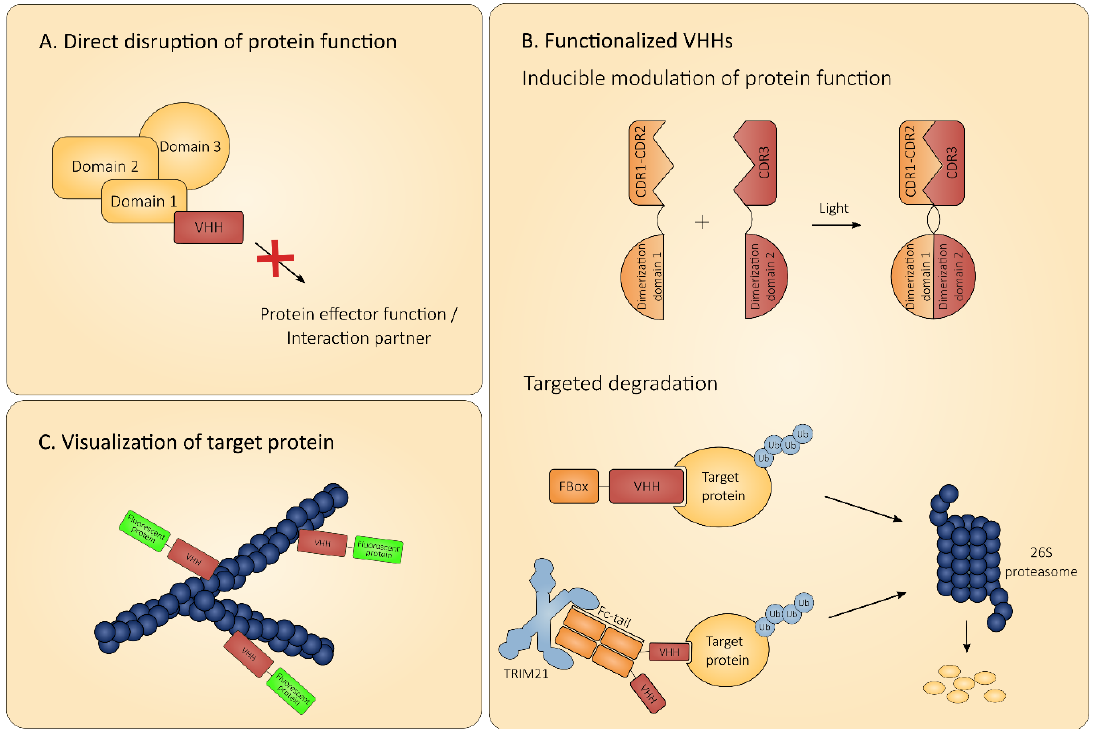
Figure 3. Schematic overview of the different uses of VHHs as research tools. ( A ) VHHs are able to target a particular protein domain, hereby inhibiting a specific protein effector function or a specific protein interaction. ( B ) VHHs can be coupled to functional groups. Creating a split VHH, coupled to light-sensitive dimerization domains, allows the precise timing of VHH modulation of target protein function [125]. On the other hand, coupling of VHHs to an F-box domain leads to the recruitment of cellular ubiquitin ligases, effectively marking the target protein for proteasomal degradation. Alternatively, coupling intracellular VHHs to and Fc-tail allows them to be recognized by tripartite motif-containing 21 (TRIM21), a cytosolic IgG receptor that can equally mark their target for proteasomal degradation, via its E3 ubiquitin ligase activity. ( C ) Chromobodies (CB) can be used to visualize and trace target proteins inside the cell.